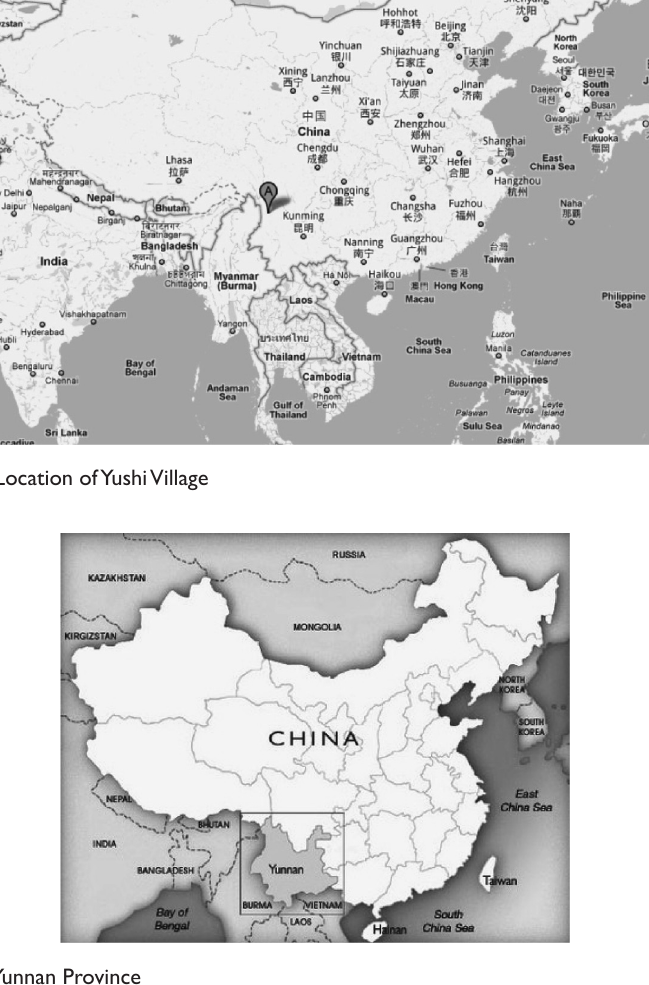
Figure 2: Yunnan